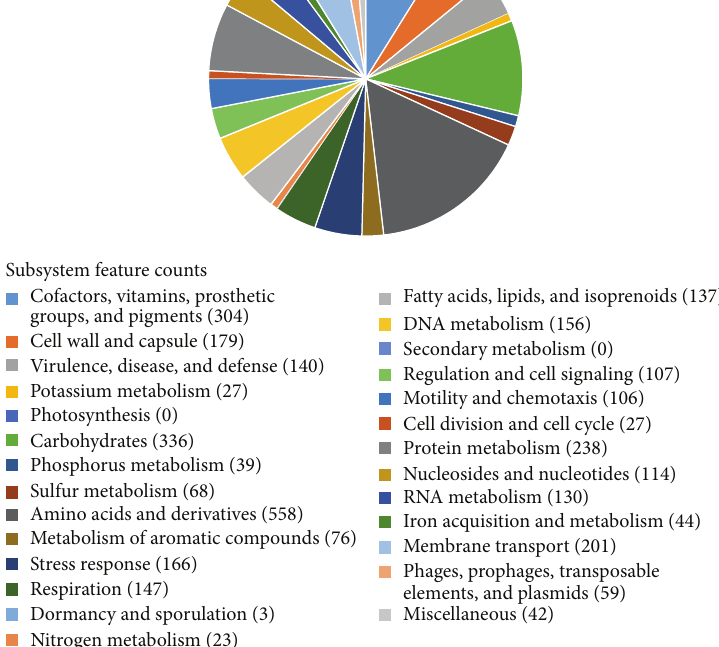
Figure 1: Subsystem distribution of P. putida T2-2 genome. Whole genome sequence was annotated and the subsystem distribution was generated from RAST.